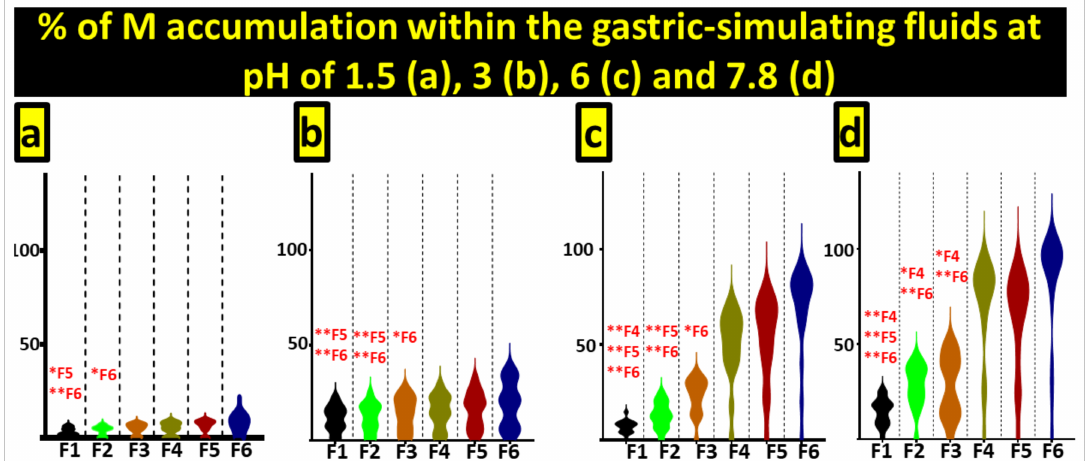
Figure 5. Metformin release in simulated gastric fluids at pH 1.5 ( a ), pH 3 ( b ), pH 6 ( c ) and pH 7.8 ( d